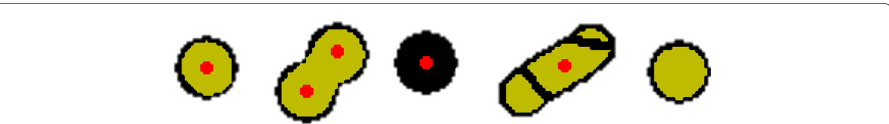
Fig. 4 All possible cases of segmentation (yellow overlay) and ground truth scoring (red dots). From left to right: true positive, false negative — under-segmentation, false negative — missed detection, false